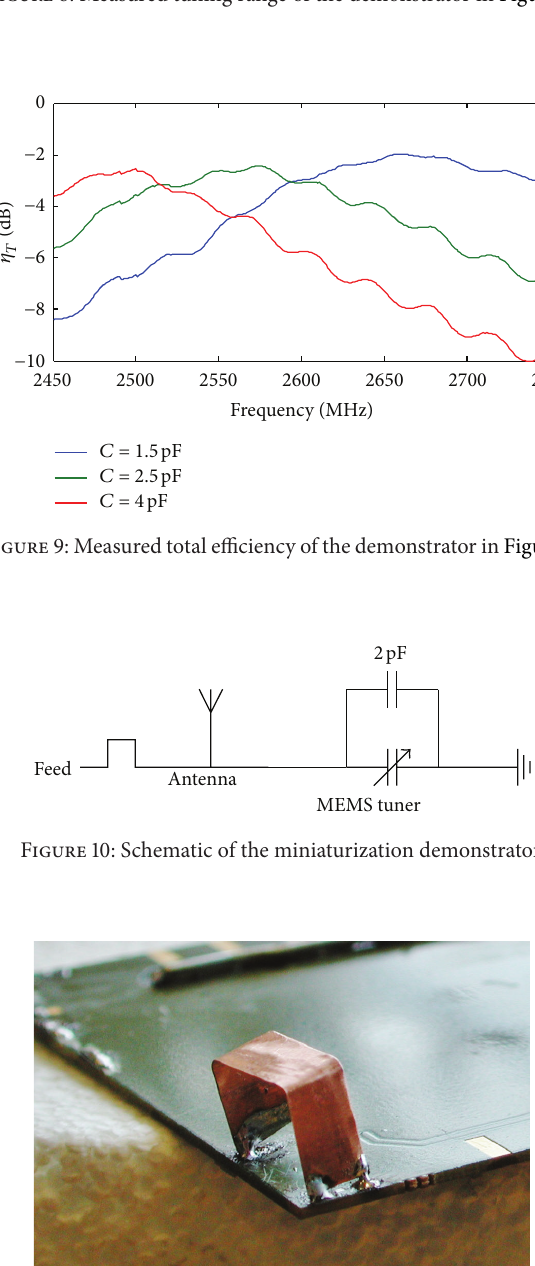
Figure 8: Measured tuning range of the demonstrator in Figure 6.